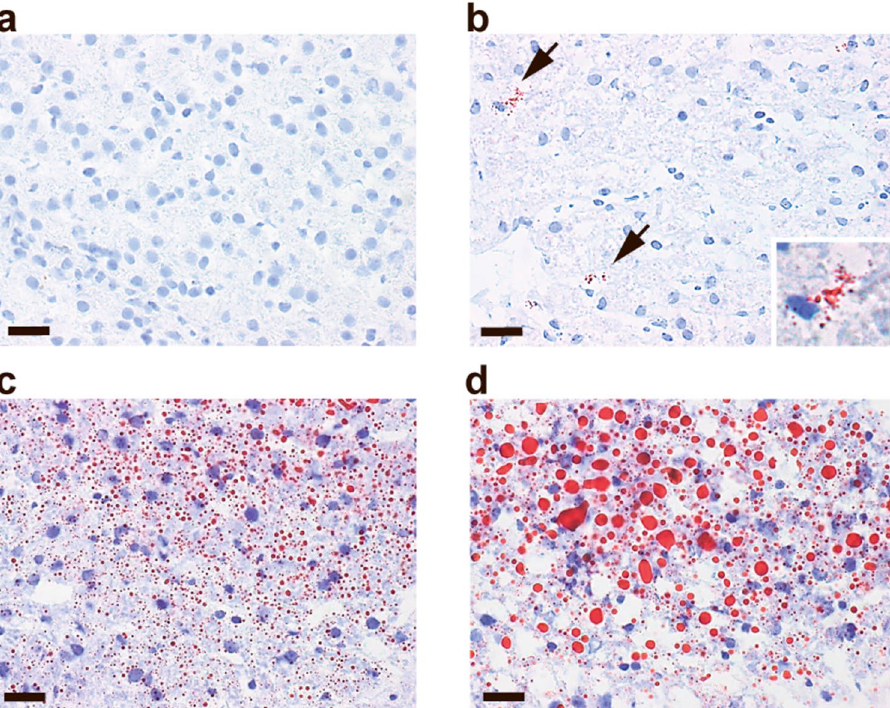
Figure 3. Hepatic lipid accumulation visualized by Oil Red O staining of frozen liver sections from pigs on SC ( a ) and HF ( b ). Arrow heads indicate areas of Oil Red O staining in HF pigs (upper area is magnified in lower right corner). Oil Red O positive control stainings from rats with fructose-induced steatosis were included to demonstrate micro- ( c ) and macrovesicular fatty droplets ( d ). Scalebars 20